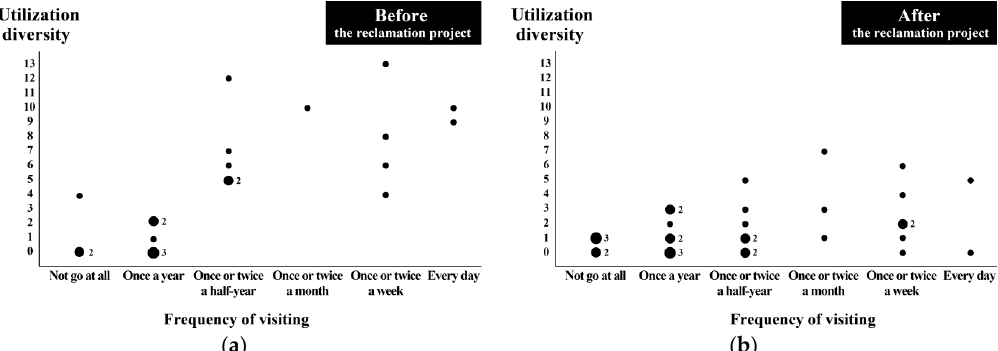
Figure 11. Frequency of visits after the reclamation project and utilization diversity before and after the reclamation project. ( a ): utilization diversity before the reclamation project; ( b ): utilization diversity after the reclamation project.